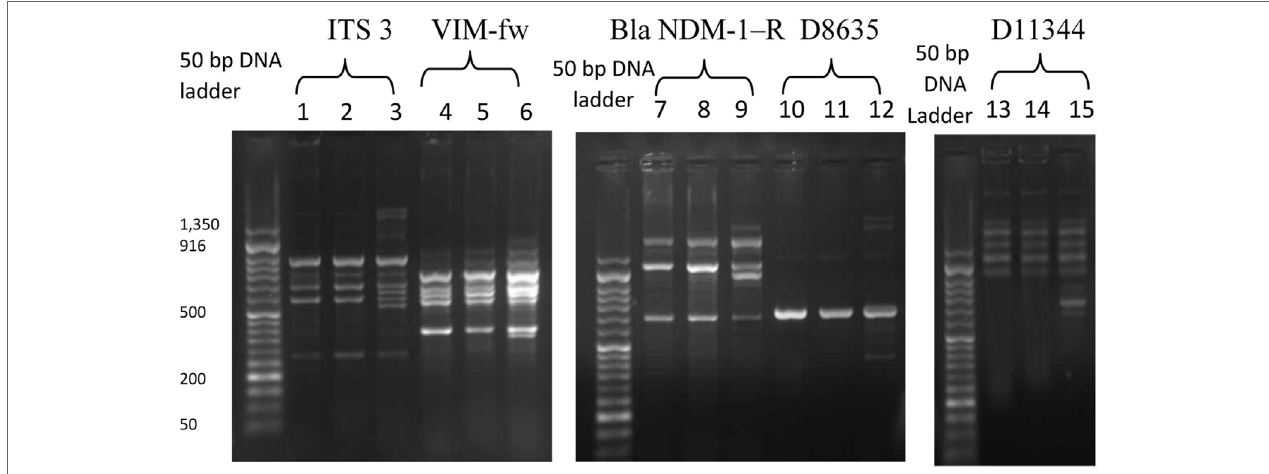
FIGURe 2 | The random amplified polymorphic DNA polymerase chain reaction fingerprint pattern for three Neisseria gonorrhoea strains isolated from urethral discharge (lanes 1, 4, 7, 10, 13), ocular swab (lane 2, 5, 8, 11, 14), and blood (lane 3, 6, 9, 12, 15) using five sets of arbitrary primers including IT3, VIM-f, Bla NDM-1R, D8635, and D11344. DNA Ladder: 50